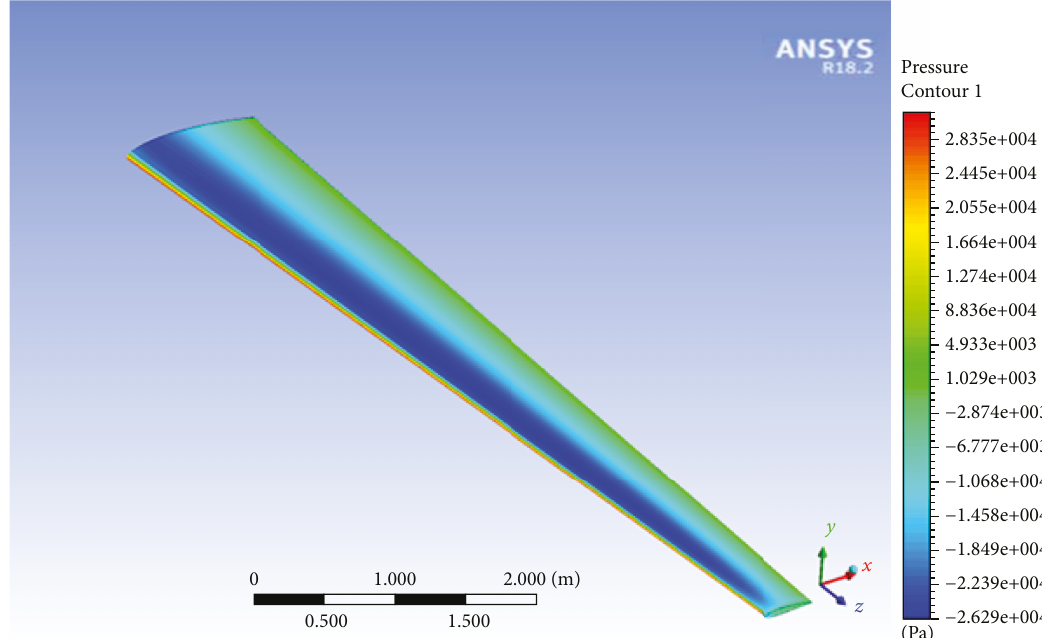
Figure 2: Pressure contour on the NACA 2412 airfoil.